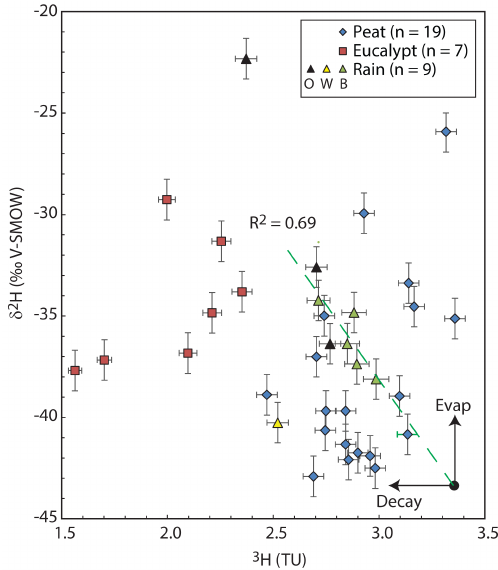
Figure 3. δ 18 O vs. δ 2 H values of waters from the Australian Alps (data from Table 1) relative to the global meteoric water line (GMWL: Clark and Fritz, 1997) and the Melbourne meteoric wa- ter line (MMWL: Hughes and Crawford, 2012). Each data point represents an individual sample collected on the date indicated in Table 1. Error bars are analytical uncertainties (0.2‰ for δ 18 O and 1‰ for δ 2 H). Rainfall samples: B indicates Mount Buffalo multi- month samples; W indicates the 2-week winter precipitation sam- ple; O indicates other samples from southeast Australia. Dashed line (slope, S = 5) is fit to all of the data by linear regression.